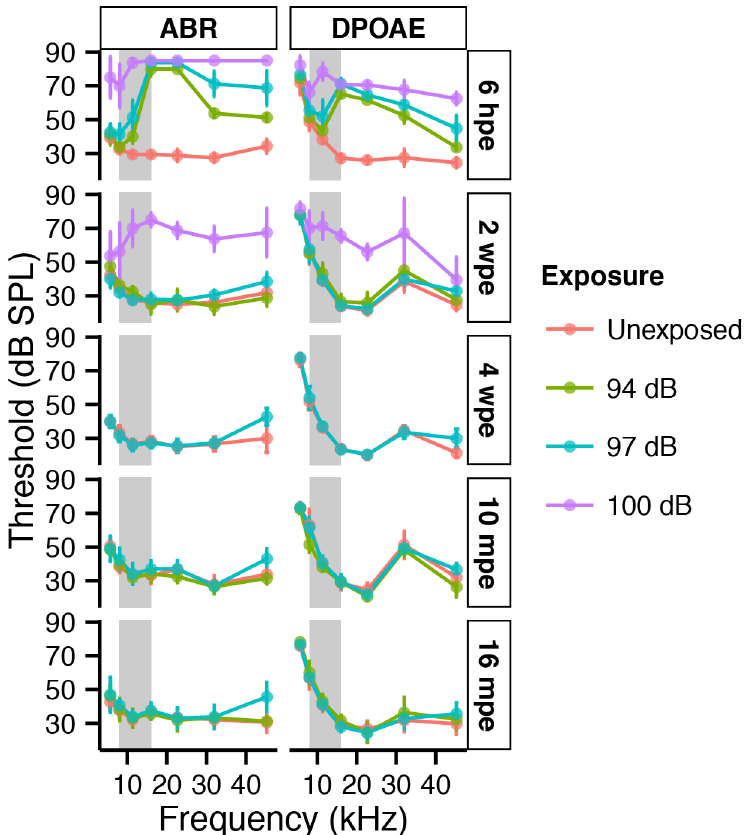
Fig 1. Cochlear thresholds are either permanently or temporarily shifted following neuropathic noise. ABR (left column) and DPOAE (right column) thresholds resulting from exposure of 6 week old mice to 8 – 16 kHz noise for 2 hours at 100 dB SPL (purple), 97 dB SPL (neuropathic exposure, blue) and 94 dB SPL (non- neuropathic exposure, green) compared to unexposed controls (red). Thresholds are shown as group means ± SD. The noise band is depicted as a gray vertical bar. Time post exposure (pe) is specified in hours (h), weeks (w) or months (m) in vertical boxes on the right side of each row. N = 5 – 9 mice per time point and noise